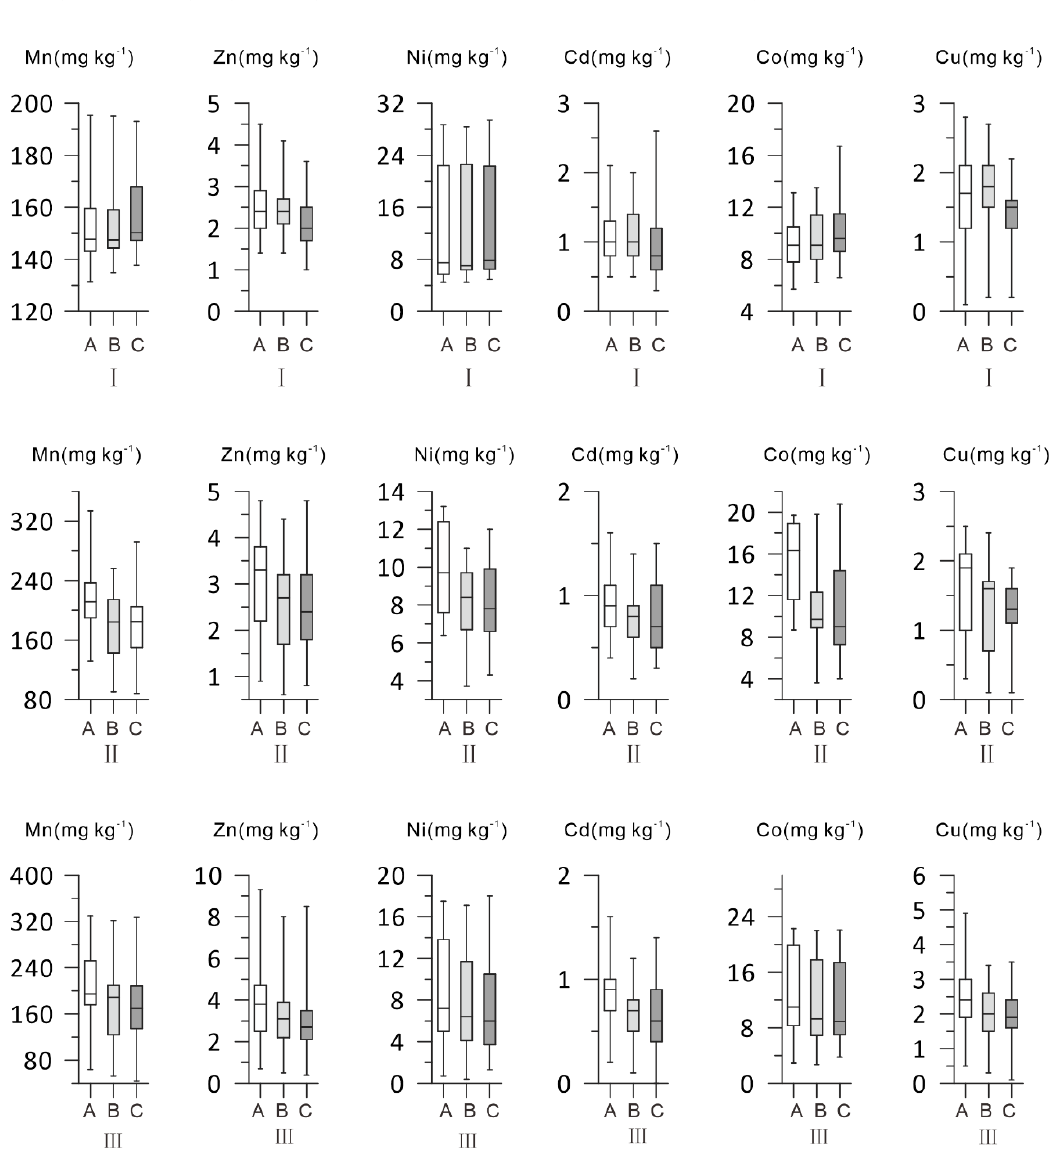
Figure 2. The vertical box plots display the minimum, maximum, median, lower quartile, and upper quartile data of the heavy metals in the three sampling regions (I: n = 29; II: n = 17; III: n = 29). A: The 0 – 20 cm soil layer; B: The 21 – 50 cm soil layer; and C: The 51 – 100 cm soil layer.